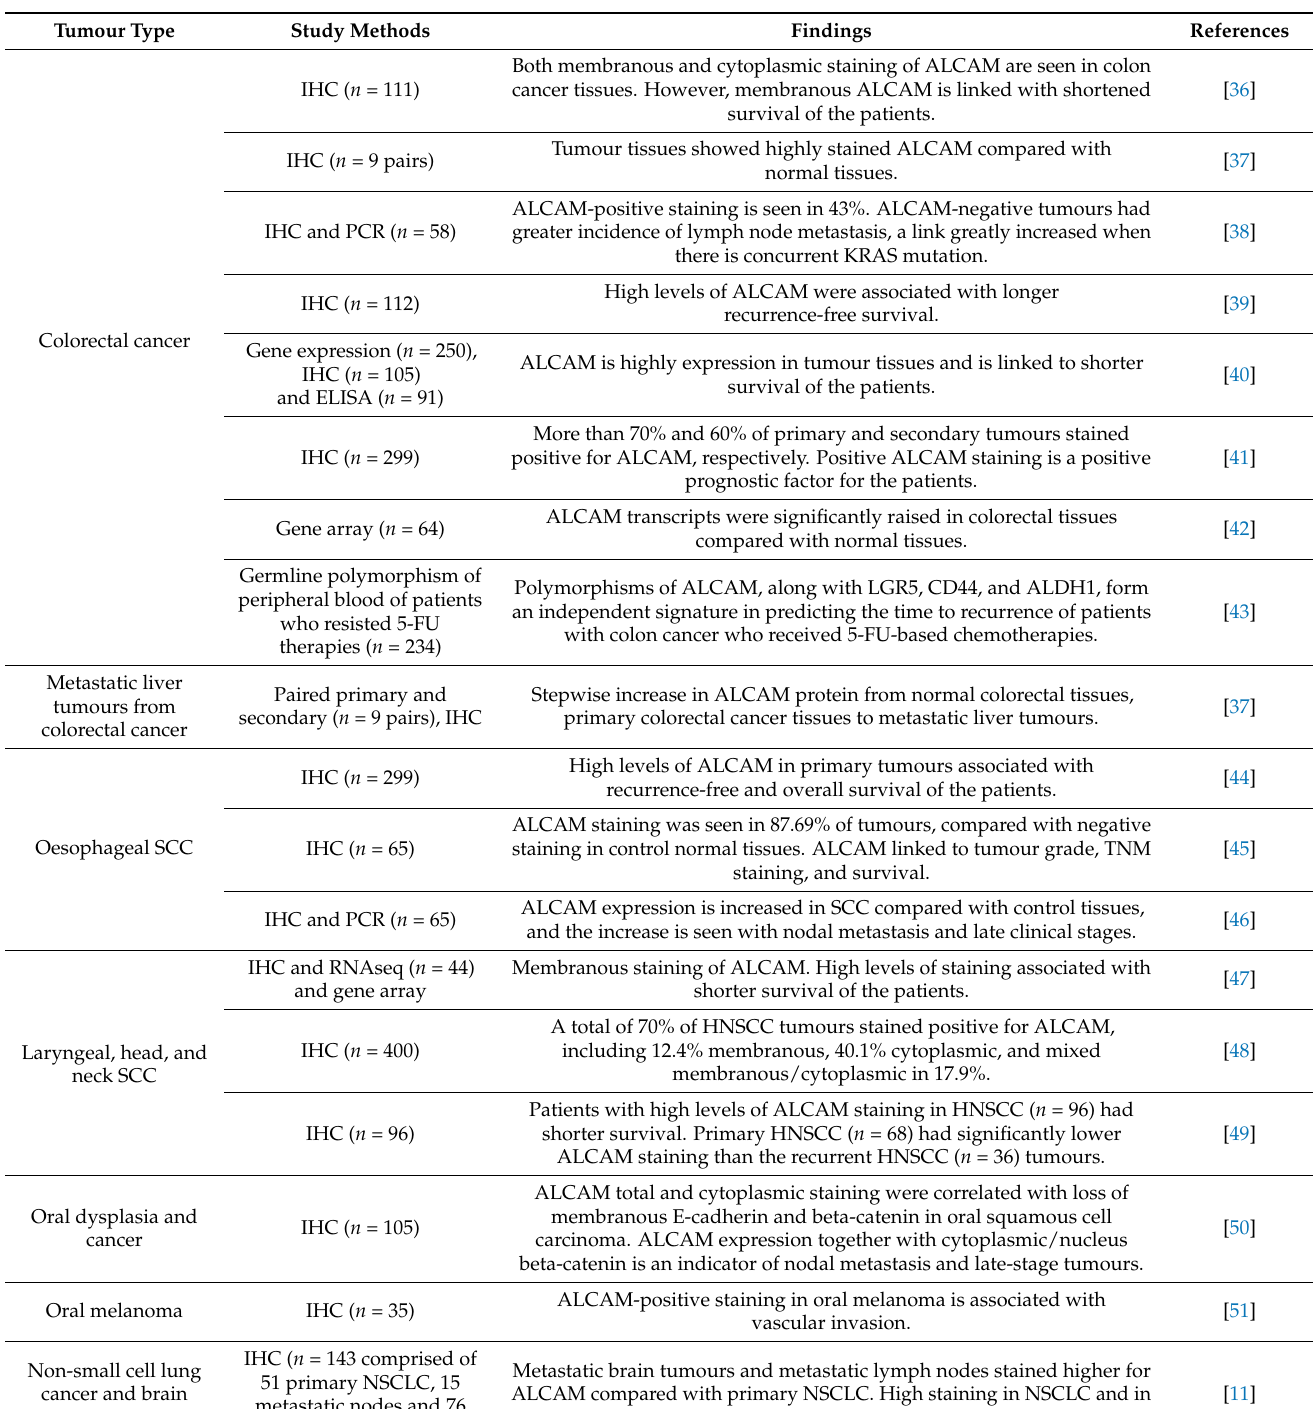
Table 1. ALCAM expression in